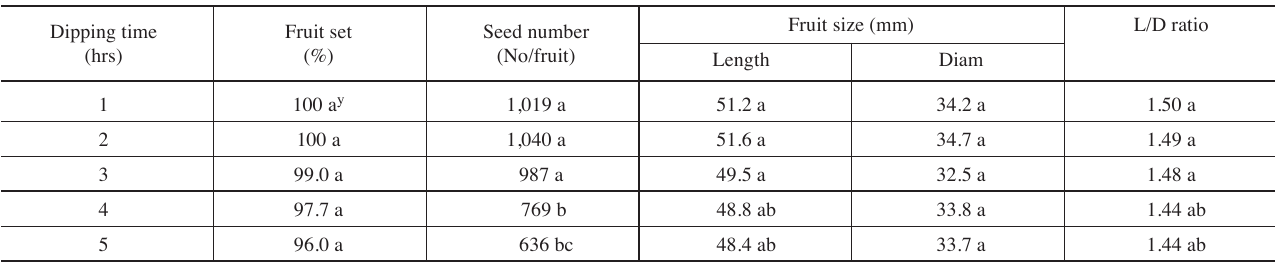
Tab. 4: Effects of the artificial pollination by the pollen diluent solution with dipping time on fruit set, seed number, fruit size, and L/D ratio of ‘Hayward’ kiwi fruit.